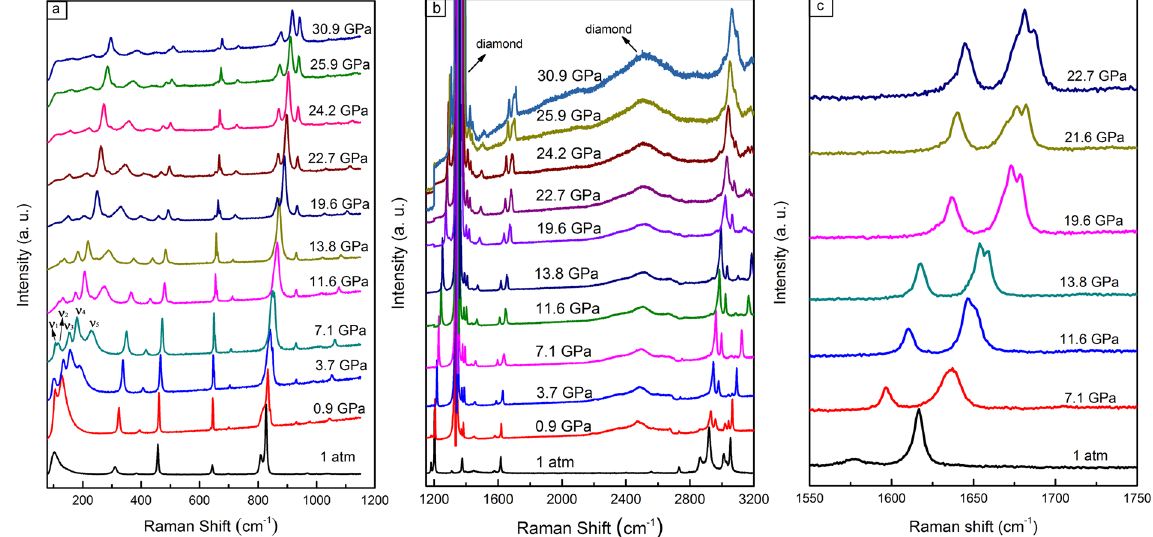
Figure 6. Raman spectra of p -xylene measured at various pressures and room temperatures. Spectra: ( a ) 80– 1200 cm − 1 ; ( b ) 1200–3200 cm − 1 ; and ( c ) enlargement of 1550–1750 cm − 1 at selected pressures. The strong bands centered at 1332 cm − 1 and 2500 cm − 1 are from the diamond.